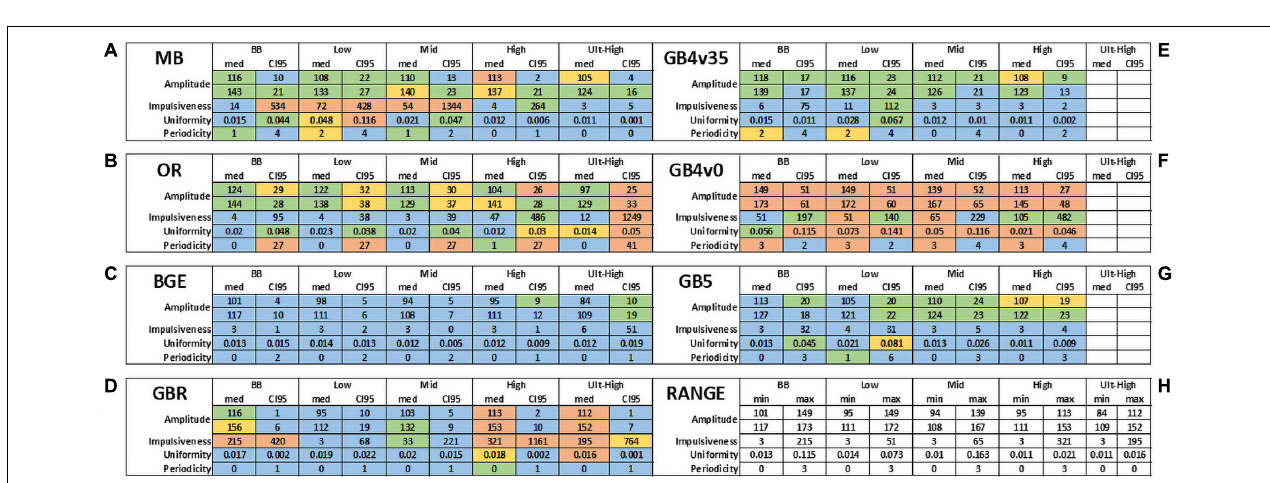
FIGURE 11 | Soundscape code results for the seven soundscape code datasets: (A) MB, (B) OR, (C) BGE, (D) GBR, (E) GB4v35, (F) GB4v0, and (G) GB5. Columns indicate the frequency band, and for each band, the median (med) and 95% confidence intervals (CI95) are reported. (H) The minimum and maximum soundscape code median values observed across all sites in corresponding frequency bands. Metrics represented in each row of the soundscape codes are from top to bottom: SPL rms , SPL pk , kurtosis, D-index Index, acorr3. The total range of the soundscape code medians and 95% CIs was divided into quartiles (respectively), and the cell colors correspond to which quartile the value falls into from low to high: blue, green, yellow,